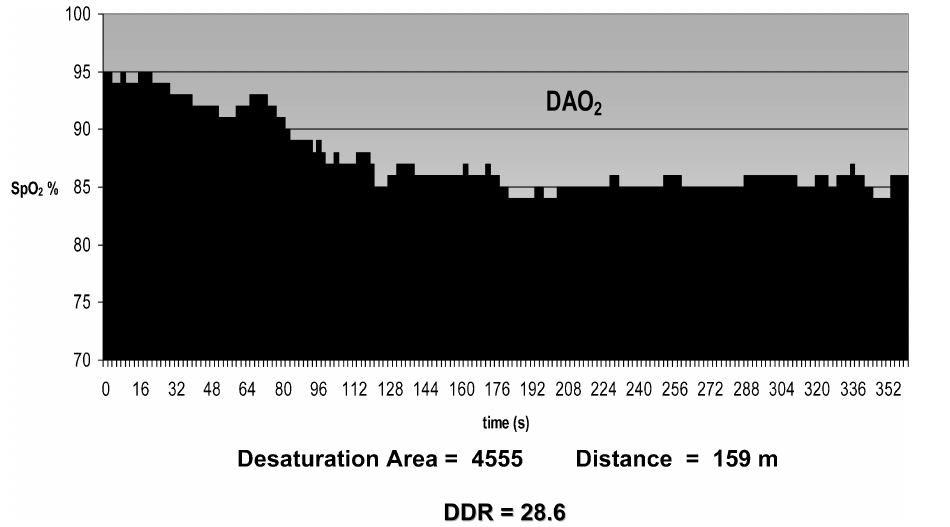
Figure 1 - Desaturation - Distance Ratio (DDR): calculated using the ratio between DAO 2 [gray area - obtained by subtraction between each recorded SpO 2 at every 2 seconds from 100% (maximal SpO 2 )] and the distance walked. Abbreviations: DAO 2 : desaturation area; SpO 2 : peripheral oxygen saturation